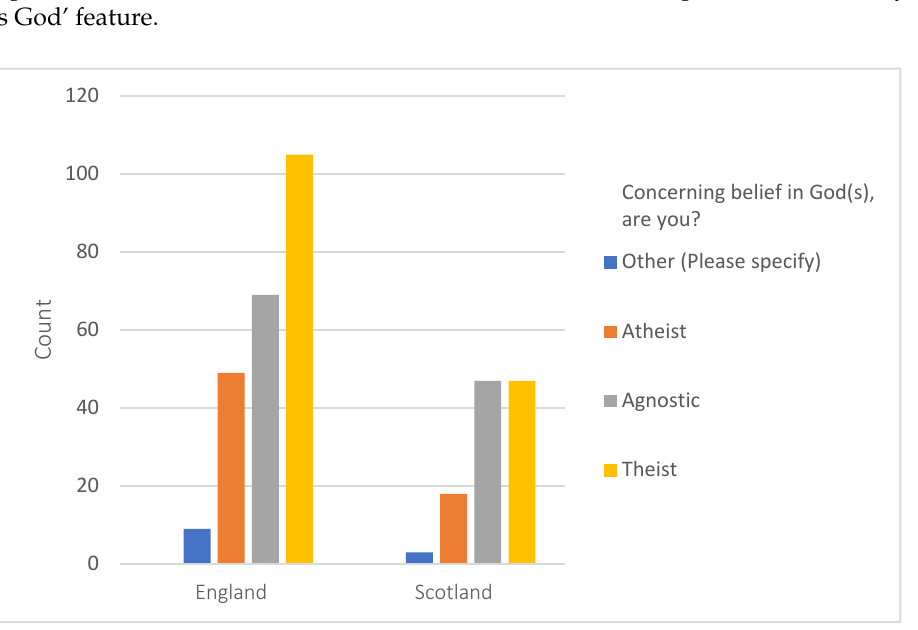
Figure 4. Q15 Concerning Belief in God(s), are you? (England, Scotland and Secondary only): n = 347.